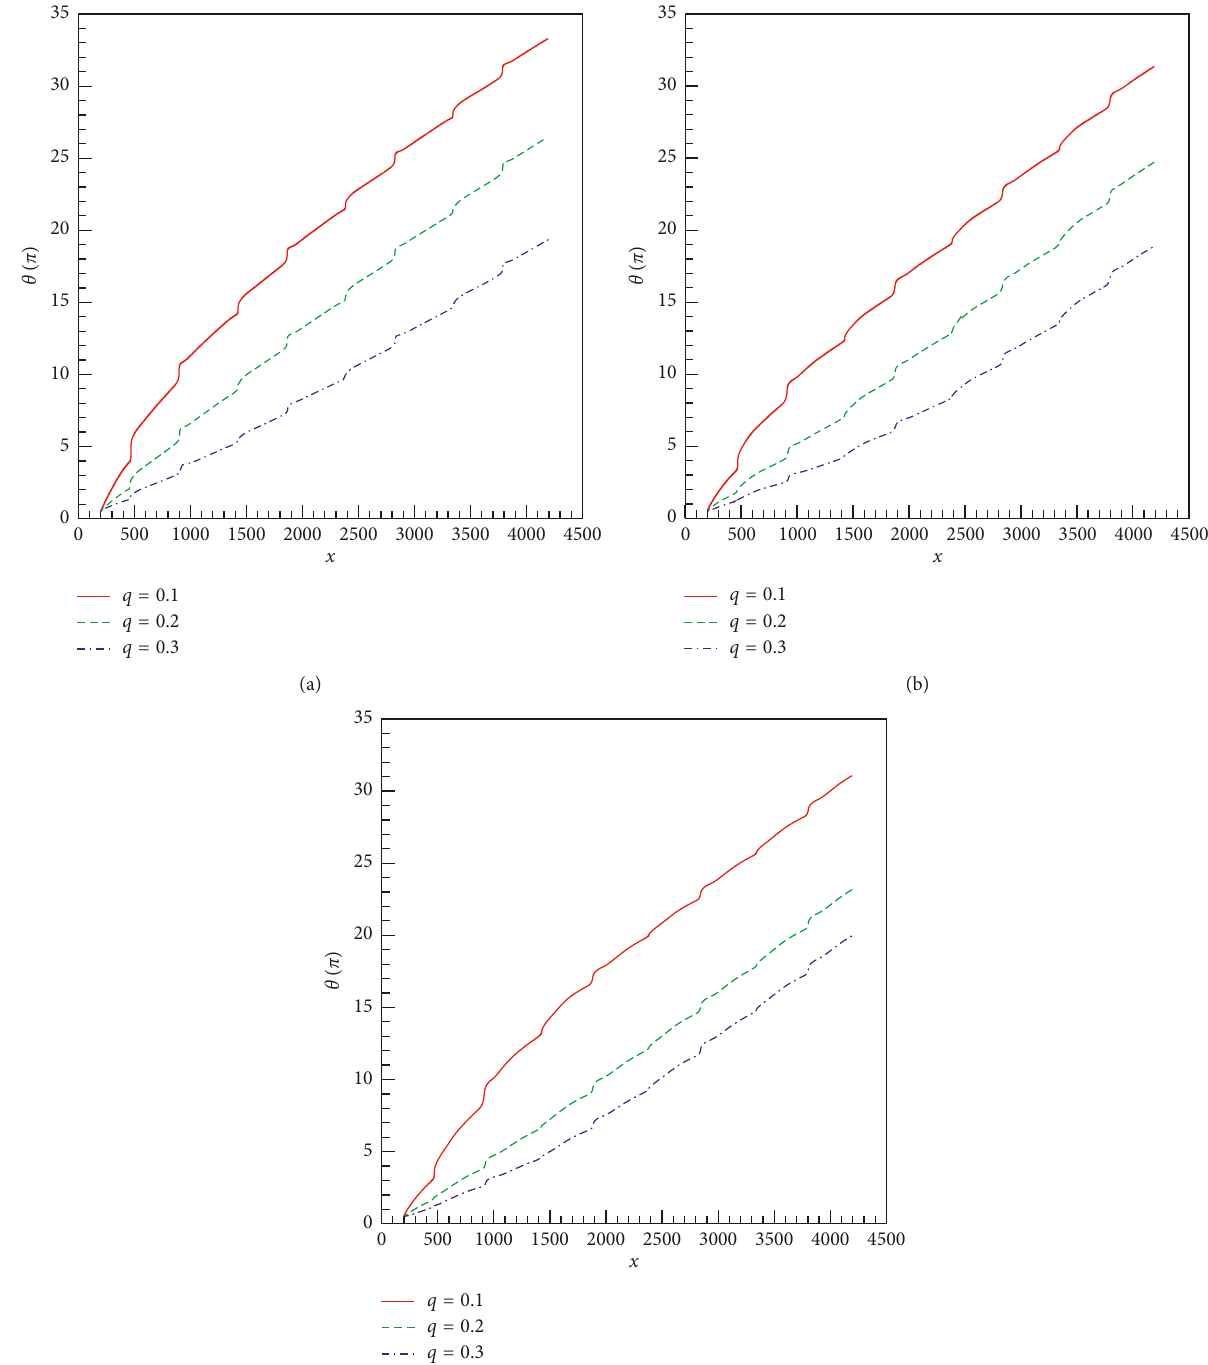
Figure 7: The orientation of the particle for q appeared in